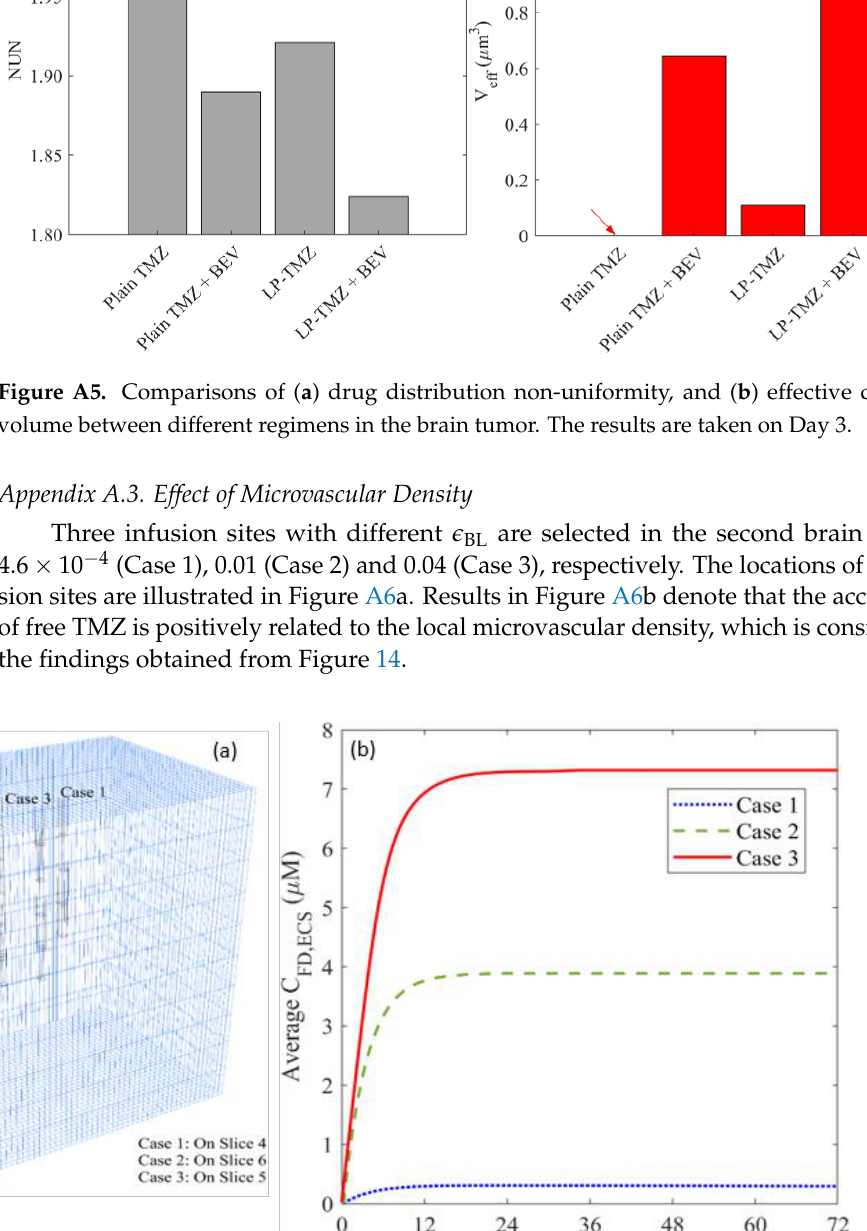
Figure A6. ( a ) Location of different infusion sites of plasma volume fraction, and ( b ) its impact on the time course of free temozolomide concentration in the brain tumor.